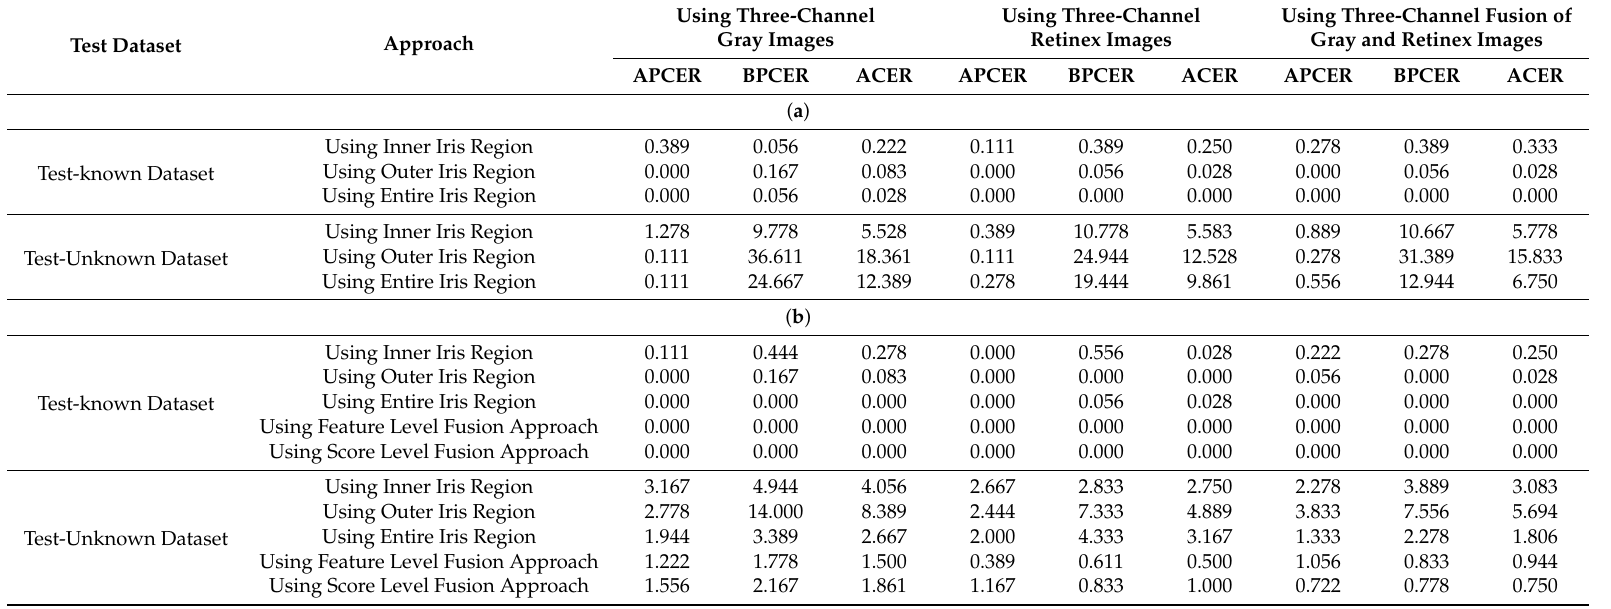
Table 8. (a) Detection errors (APCER, BPCER, and ACER) of iPAD based on CNN method for classification using NDCLD-2015 dataset with our first division method and three kinds of input images (unit: %); (b) Detection errors (APCER, BPCER, and ACER) of iPAD based on SVM method for classification using NDCLD-2015 dataset with our first division method and three kinds of input images (unit: %).